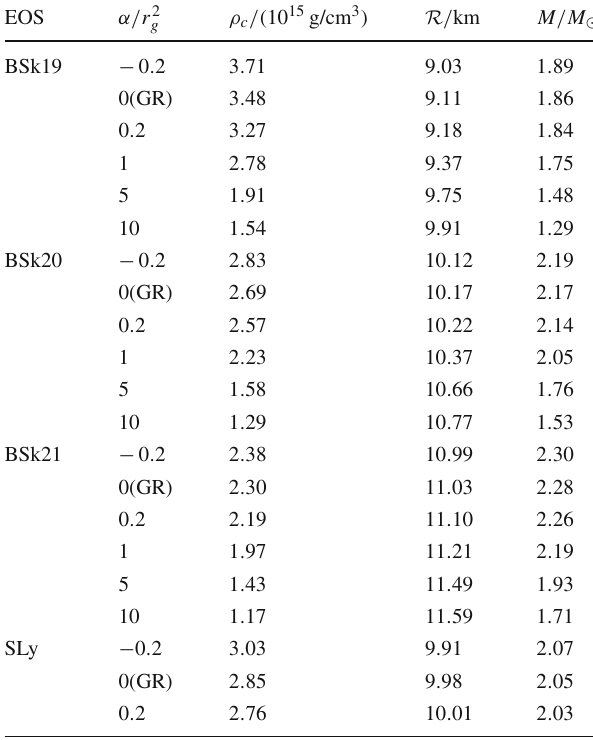
Table 3 Some critical configurations of NS models with BSk family and SLy